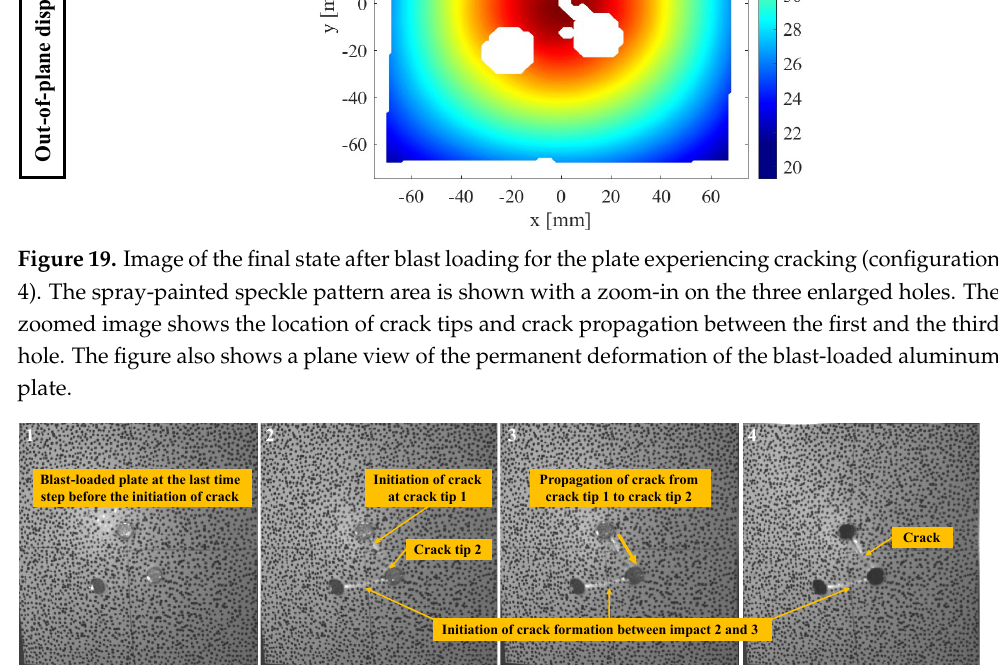
Figure 20. High-speed camera images (1–4) capturing the time evolution of fracture propagation in configuration